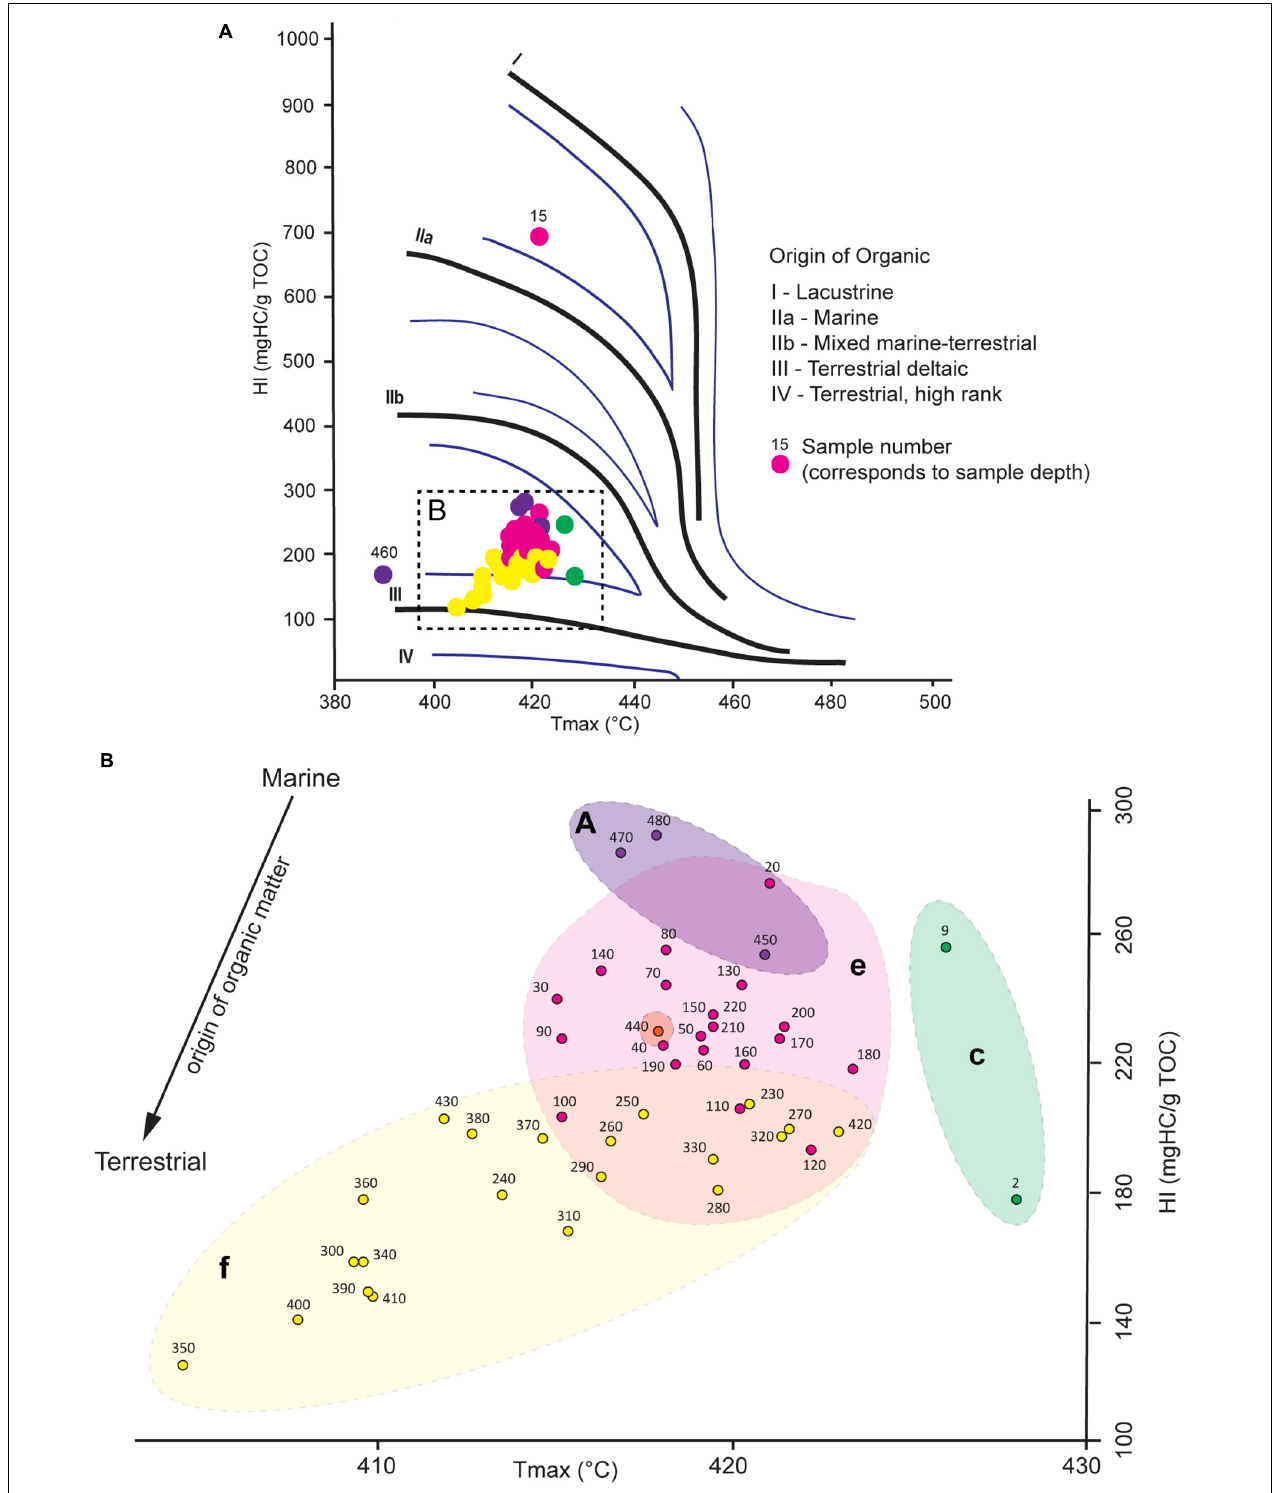
FIGURE 6 | (A) Hydrogen Index (mgHC/g TOC) vs. Tmax ( ◦ C) diagram. (B) Close-up of the dashed rectangle illustrated in part A. The distribution of samples allows to identify the origin of the organic matter present in the sediment. The origin of organic matter becomes more terrestrial with decreasing HI values. Benthic foraminiferal assemblages defined by the hierarchical cluster analysis are overlaid. The color code used for samples and overlays corresponds to the one defined for benthic foraminiferal assemblages in Figure 4 .